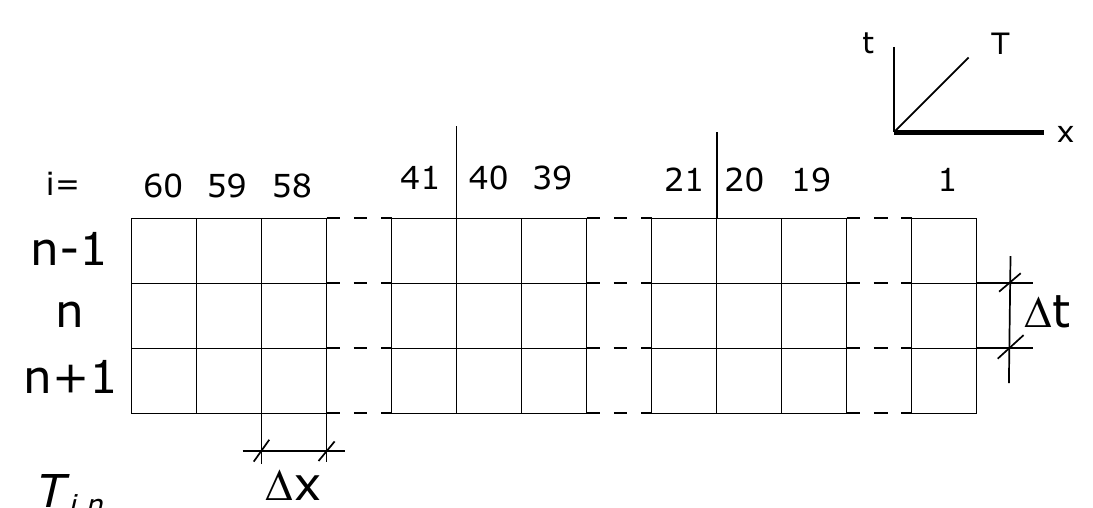
Figure 4. Regular temperature grid generated after the recorded field approximation.